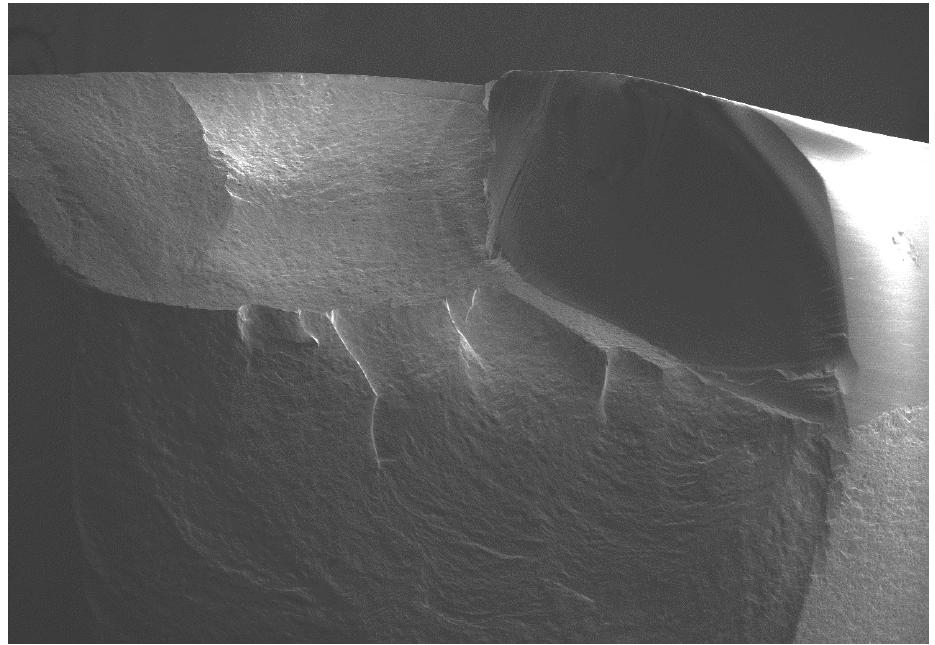
Figure 6. SEM micrograph of the fractured veneered-zirconia crown repaired with G-aenial Universal Flo at magnification of 22×.